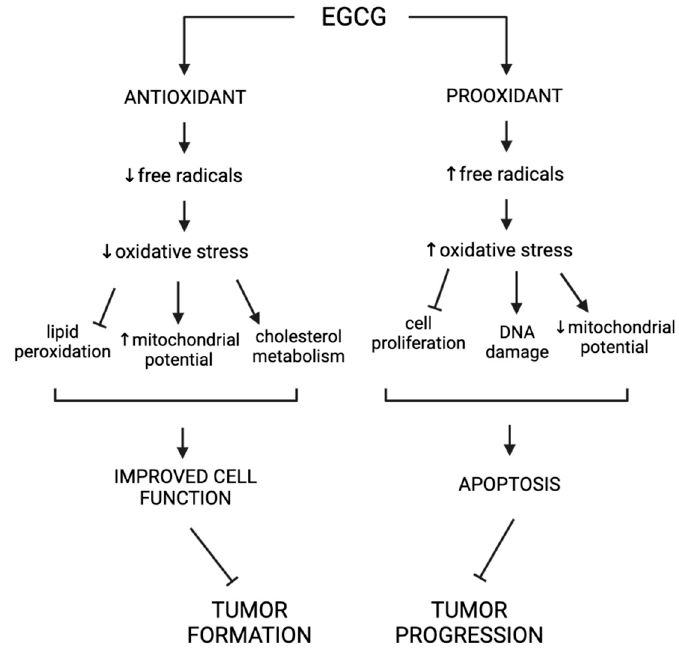
Figure 4. Pro- and antioxidant functions of EGCG.